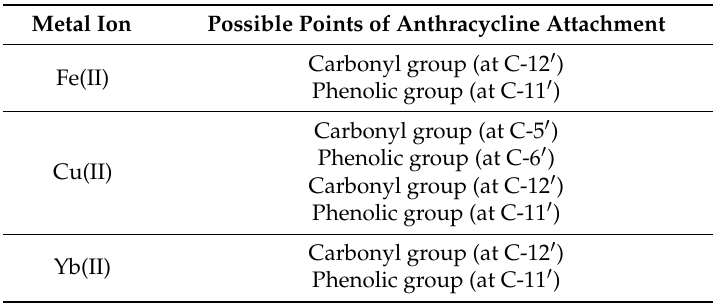
Table 1. Possible points of metal attachment to the anthracycline